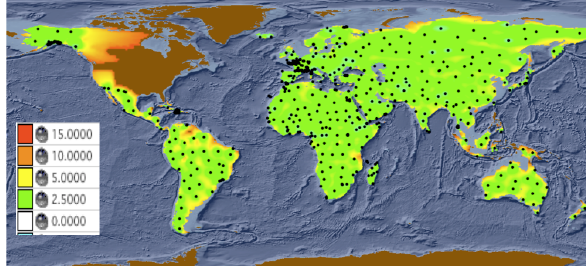
Fig. 7: Ideal equipment needed to reach a performing location (green to